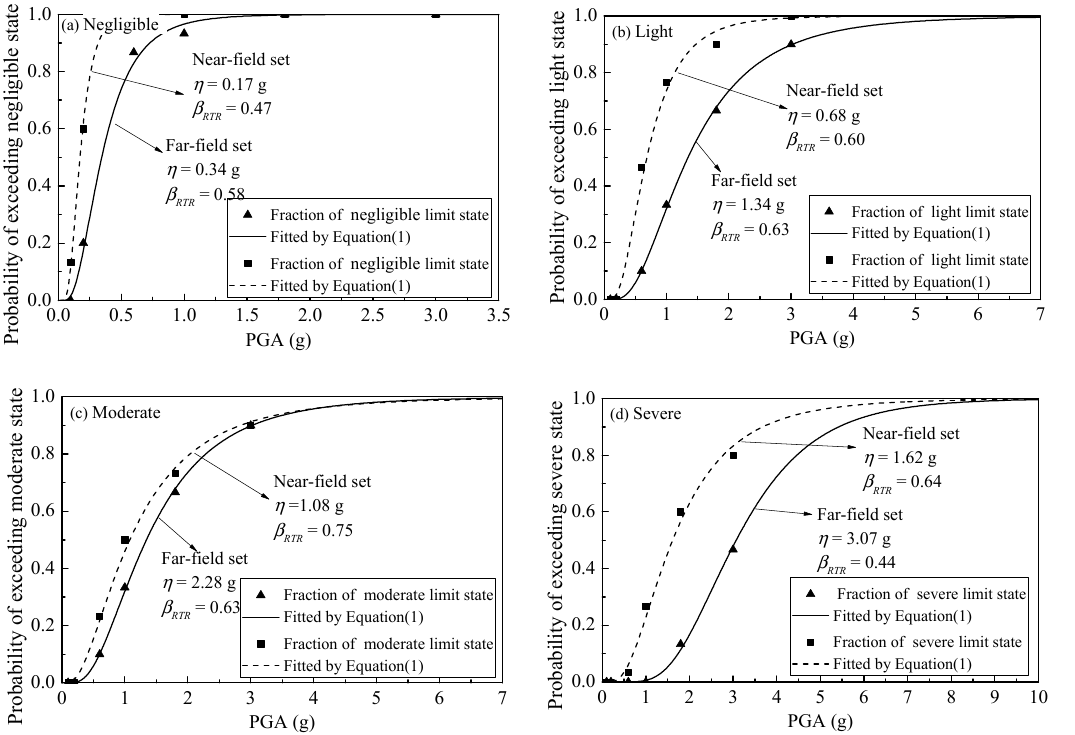
Figure 3. Maximum interstory drift ratios θ max obtained at six IM levels in both record sets.